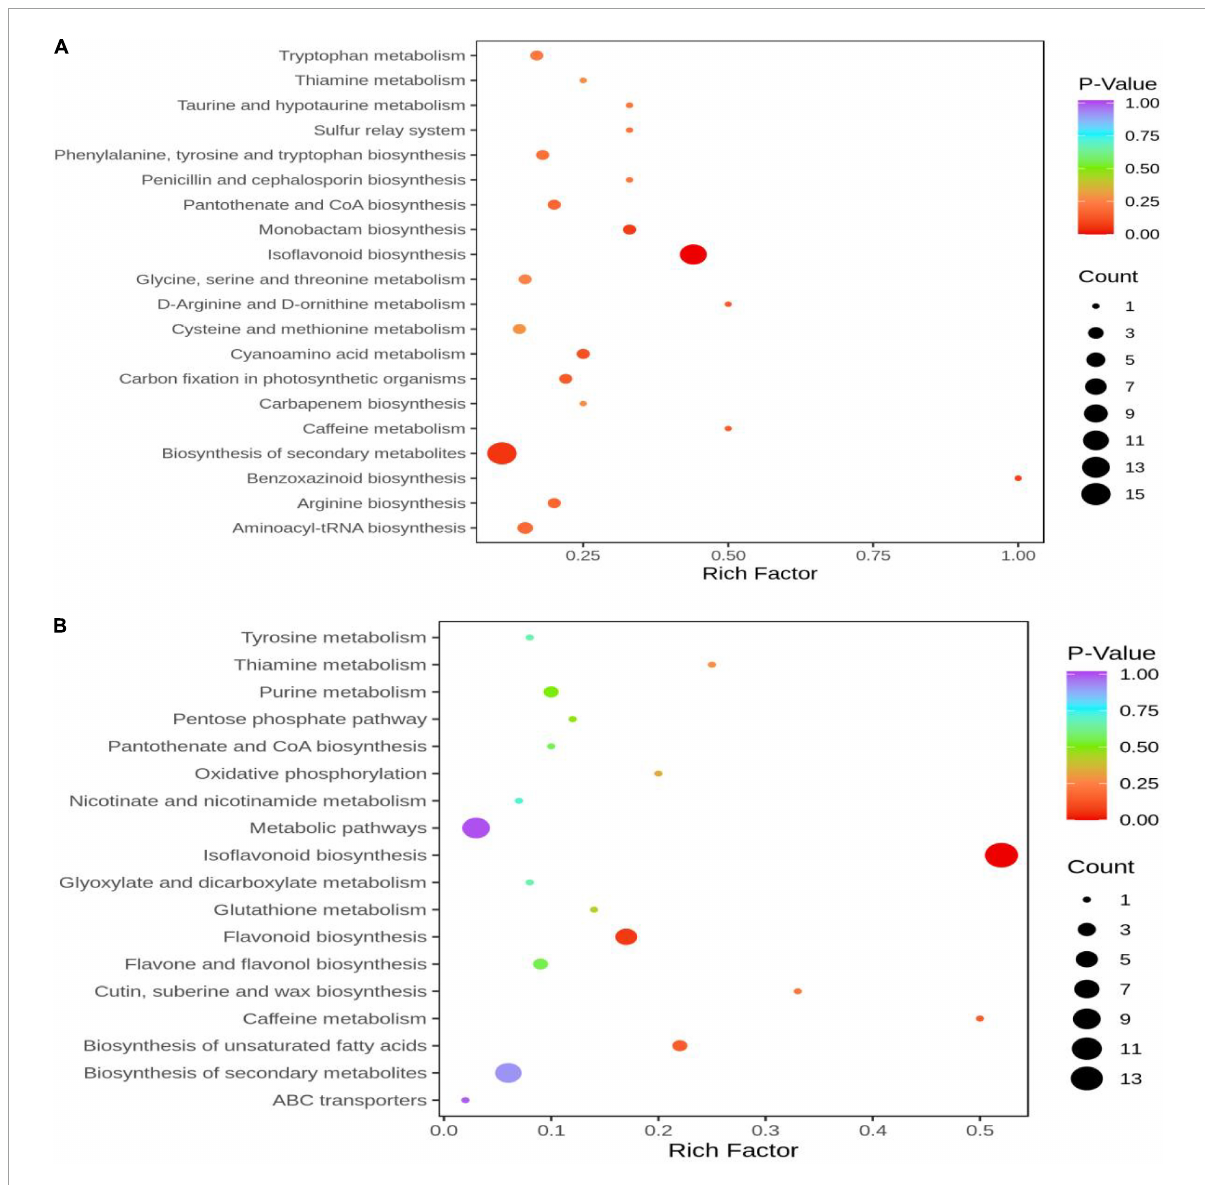
FIGURE9 KEGG enrichment map of DAMs. The abscissa represents the Rich Factor corresponding to each pathway, and the ordinate represents the name of the pathway. The color of the point reflects the p -value size, and the redder the more significant the enrichment. The size of the dots represents the number of enriched differential metabolites. (A) HN44 group; (B) HN65 group.